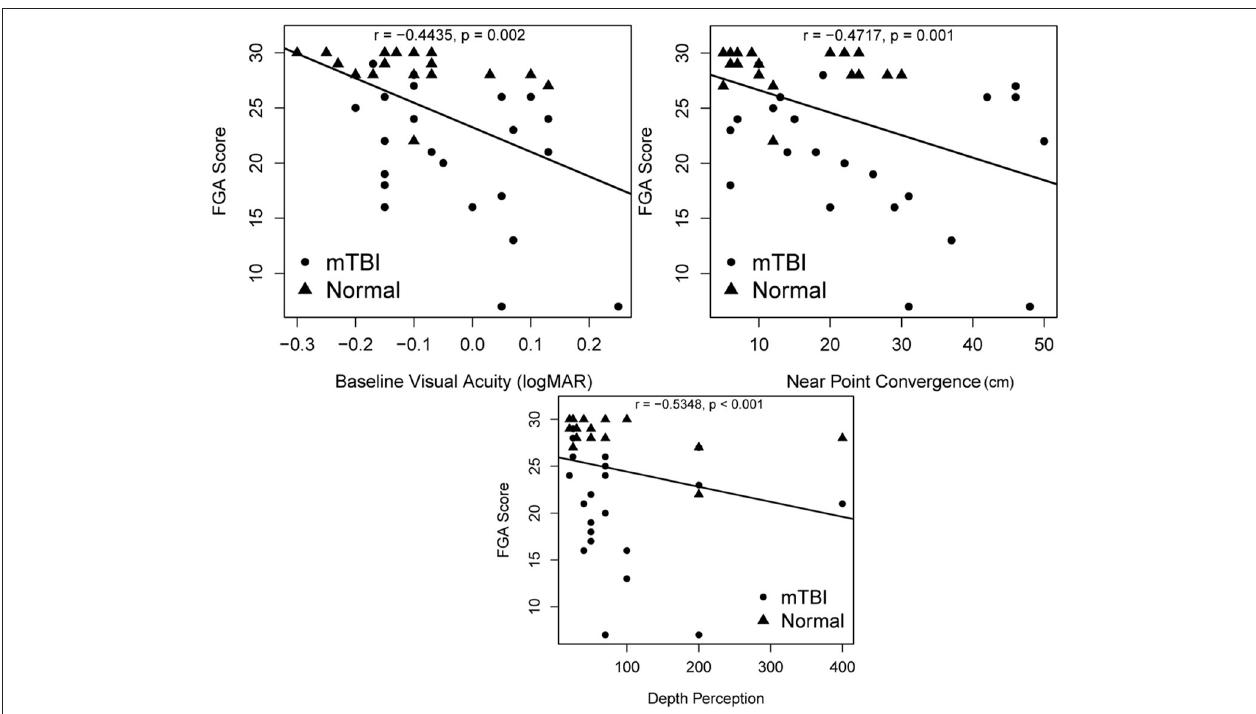
FIGURE 3 | Associations between FGA scores and oculomotor deficits including depth perception, near point convergence, and baseline visual acuity. p -values are significant at α = 0.004 after Bonferroni adjustment. FGA, Functional Gait